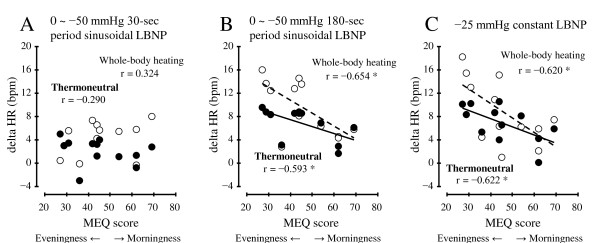
Linear regression analysis of the inter-individual relationship between the morningness-eveningness questionnaire (MEQ) score and the difference in mean values from baseline to LBNP in HR during thermoneutral (filled circle, solid line) and whole-body heating (open circle, dashed line). *P <0.05. n = 12.